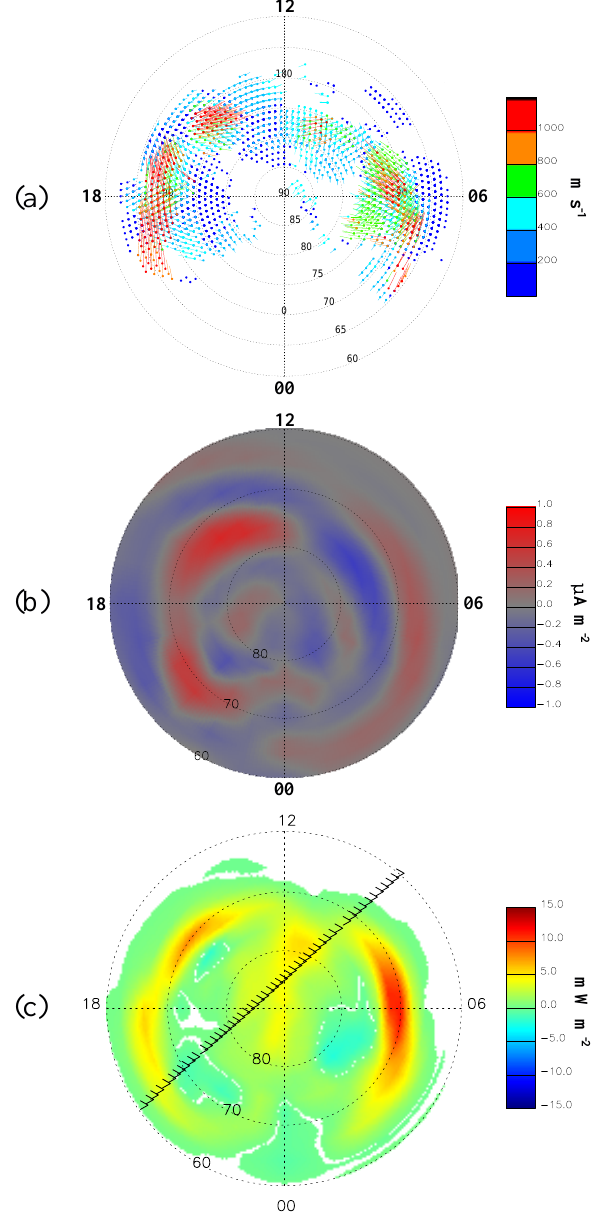
Fig. 2. Iridium and SuperDARN data over 16:00–17:00 UT, 11 March 2000. ( a ) Plasma velocities from SuperDARN, ( b ) field- aligned currents derived from the Iridium magnetometer data and ( c ) the combined data showing Poynting flux, where S || is positive into the ionosphere. The DMSP F-15 track is also shown.